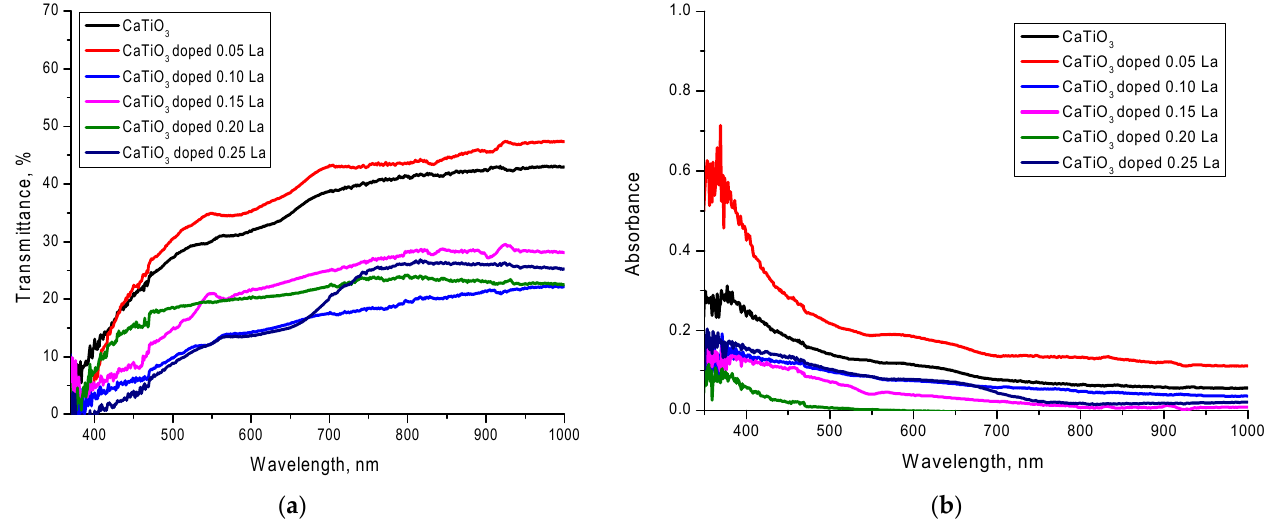
Figure 4. UV-Vis optical spectra of the investigated lanthanum-doped CaTiO 3 ceramics: ( a ) Transmittance; ( b ) Absorbance.